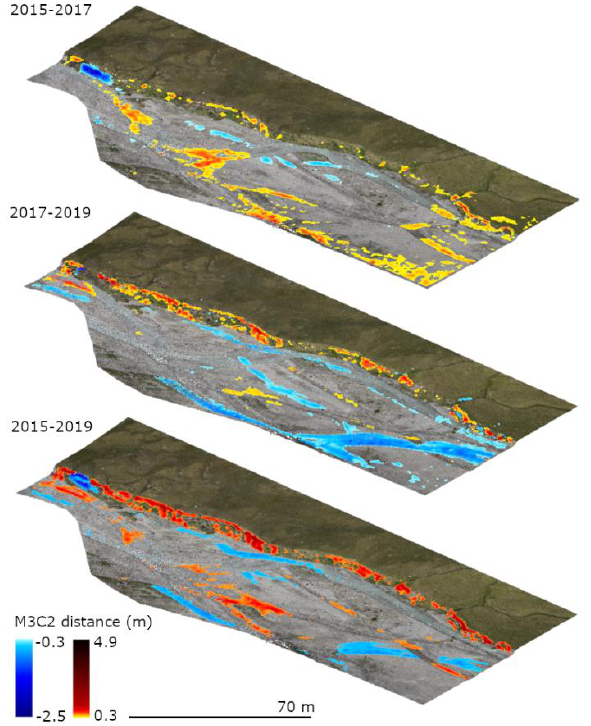
Figure 12. M3C2-calculated distance between 2015, 2017, and 2019 point clouds. Statistically insignificant changes based on confidence interval (see Table 5) were excluded from visualisation.